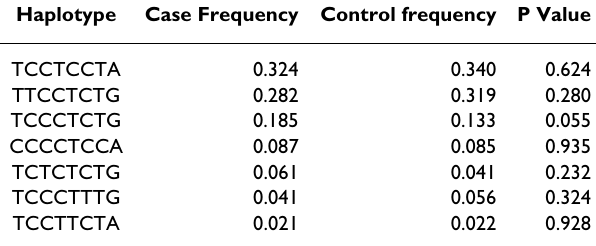
Table 4: Haplotype Frequencies for ARNT SNPs in Utah Caucasian Cases and Controls Haplotype